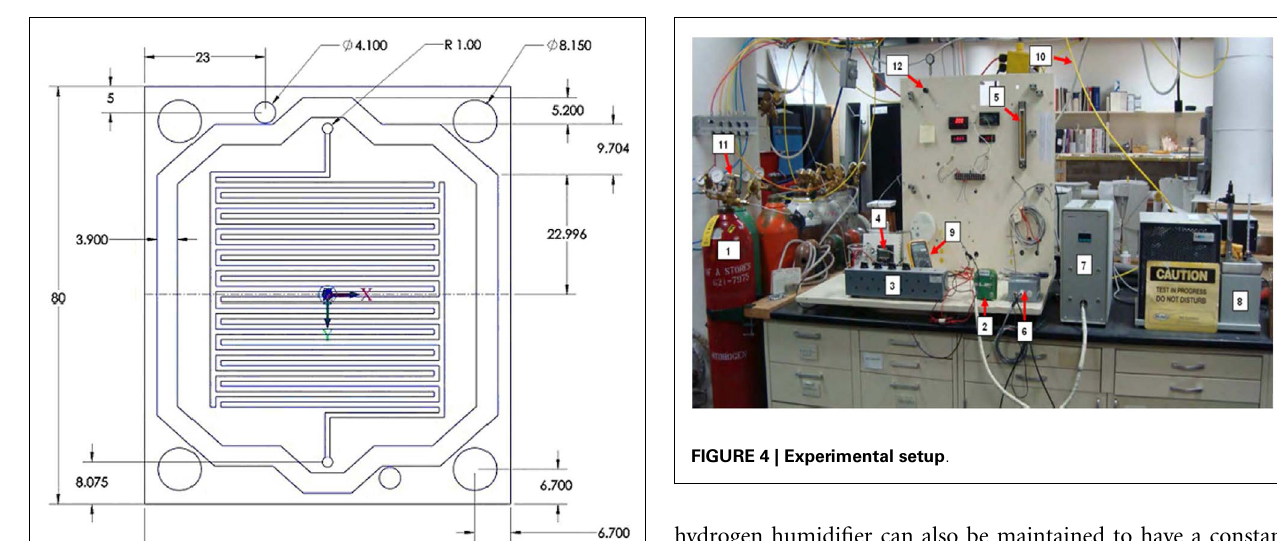
electrode assemblies (MEAs) from one manufacturer was used for all the tests, which include a membrane of Nafion 115 with plat- inum loadings of 0.4 mg/cm 2 . The MEA and gas diffusion layers were pre-laminated at factory with an effective area of 23.5 cm 2 .